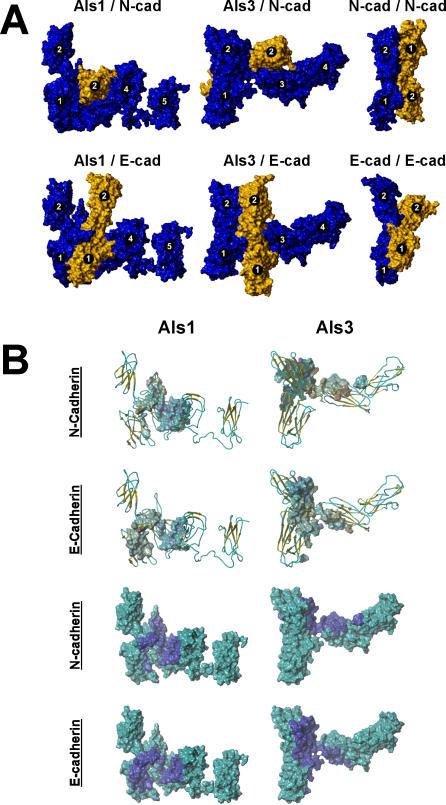
Comparative Models of Als–Cadherin InteractionsThe interactions of the N-terminal regions of Als1 and Als3 with the N-terminal regions of N-cadherin and E-cadherin, as well as N-cadherin and E-cadherin self-association were modeled as outlined in Materials and Methods. The N-terminal domains of Als1 and Als3 are shown in their energy-minimized conformations; docking results using alternate conformations yielded equivalent results (unpublished data).(A) The solvent-accessible surface areas of the proteins are shown, and the β barrel domains are numbered sequentially from the N-terminus. In models of the docking of an Als protein to a cadherin (left and middle columns), the Als protein is blue and the cadherin is gold. In models of cadherin self-association, one cadherin molecule is blue and the other cadherin is gold.(B) Interactions of Als1 or Als3 with E-cadherin or N-cadherin are presented to illustrate their predicted docking characteristics. In the top two rows, the indicated cadherin electrostatic contact surfaces are superimposed upon the backbone structures of Als1 or Als3. Coloration schema of the Als secondary structure: gold, β sheet; blue, extended/turn. Coloration schema of the cadherin surface: blue, most negative; red, most positive. In the bottom two rows, the contact footprints of the indicated cadherins (dark blue) are superimposed upon the solvent-accessible surface areas of Als1 or Als3 (aqua) to indicate the predicted docking positions of the protein pairs. In all cases, note that the ectodomain N2 of Als3 contributes to the interactions with both cadherins, while the corresponding ectodomain N2 of Als1 does not participate in interactions with either cadherin.